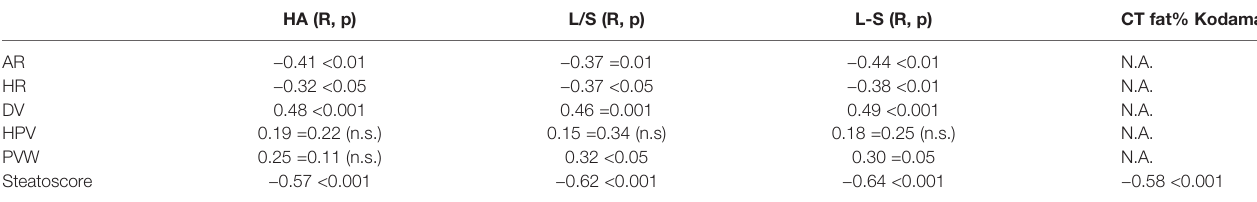
n.s., non signi fi cant; N/A, not